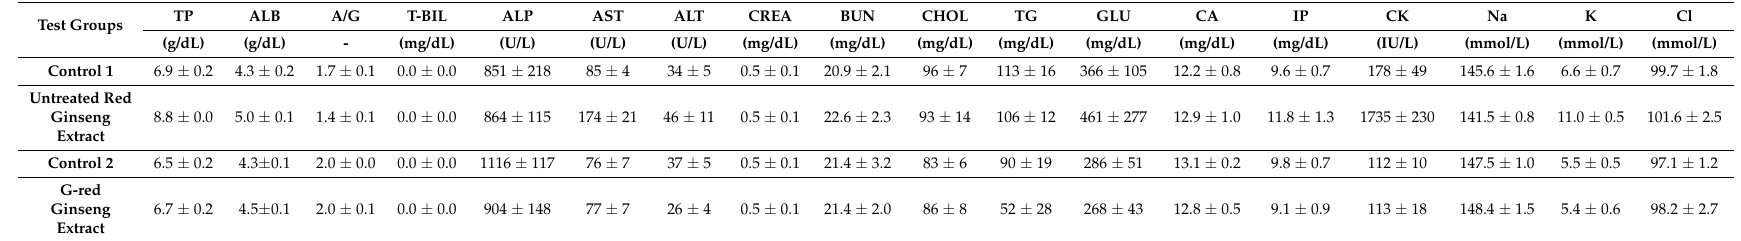
Table 4. Serum biochemical values in rats after 14-day repeated oral administration of G-red ginseng extract or untreated red ginseng extract. Test